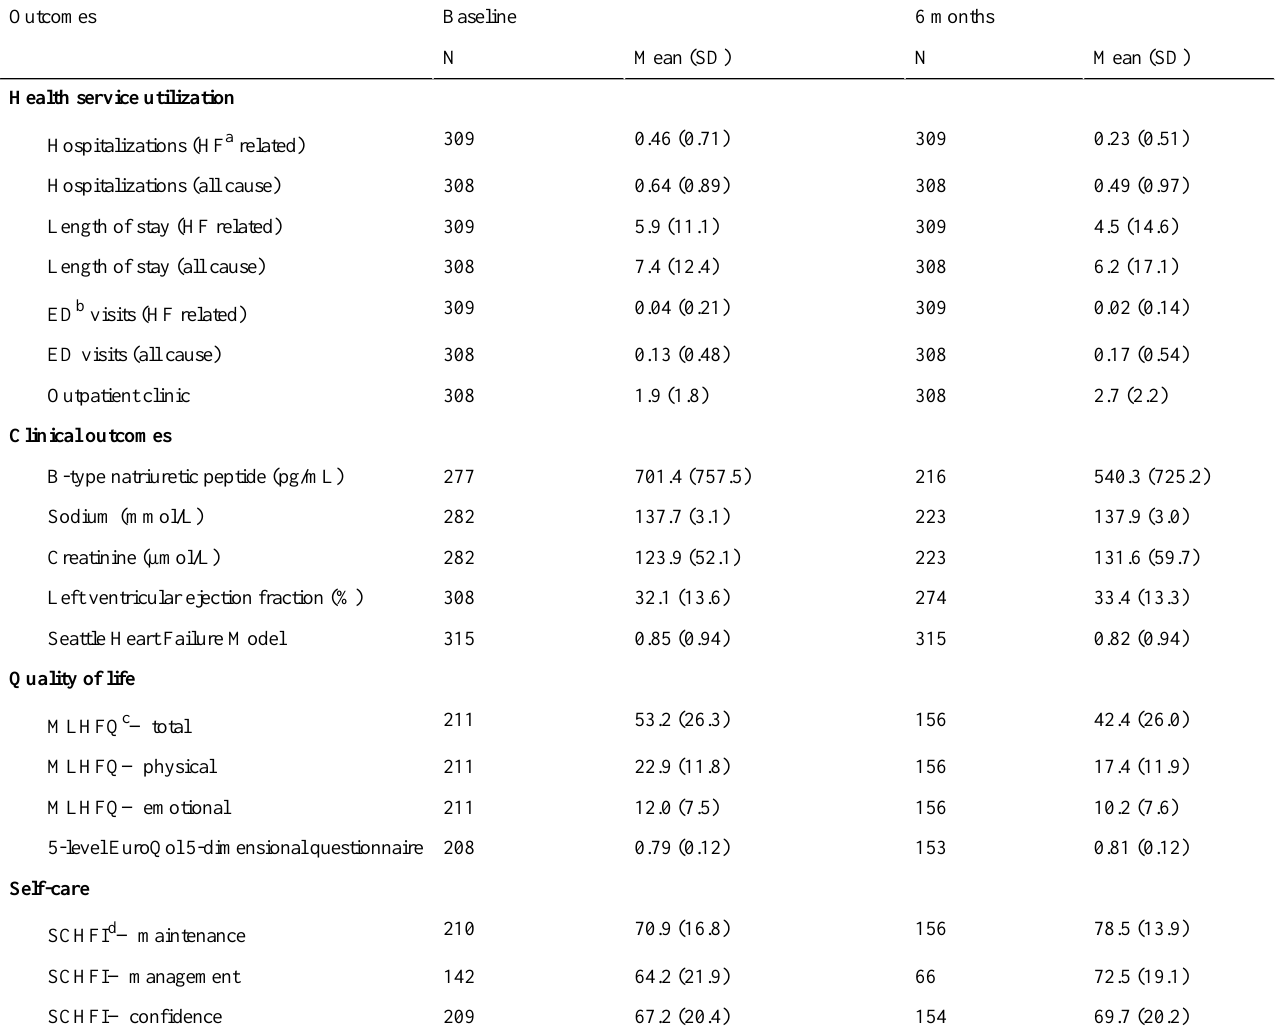
Table 1. Descriptive statistics for baseline and 6-month outcome